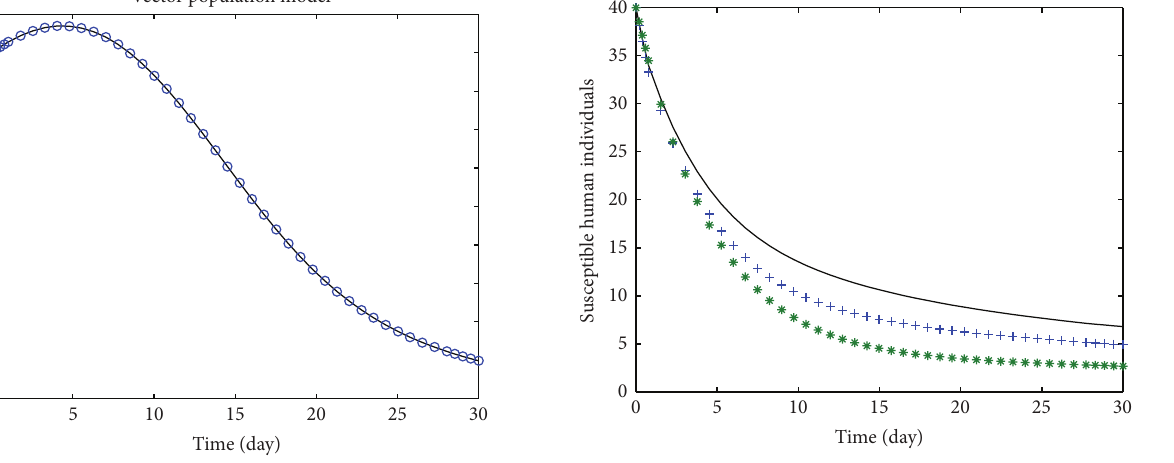
Figure 6: Susceptible human: solid line 𝛼 = 1.0 , ++ line (𝛼 = 0.95) , and ∗∗ line (𝛼 = 0.90)